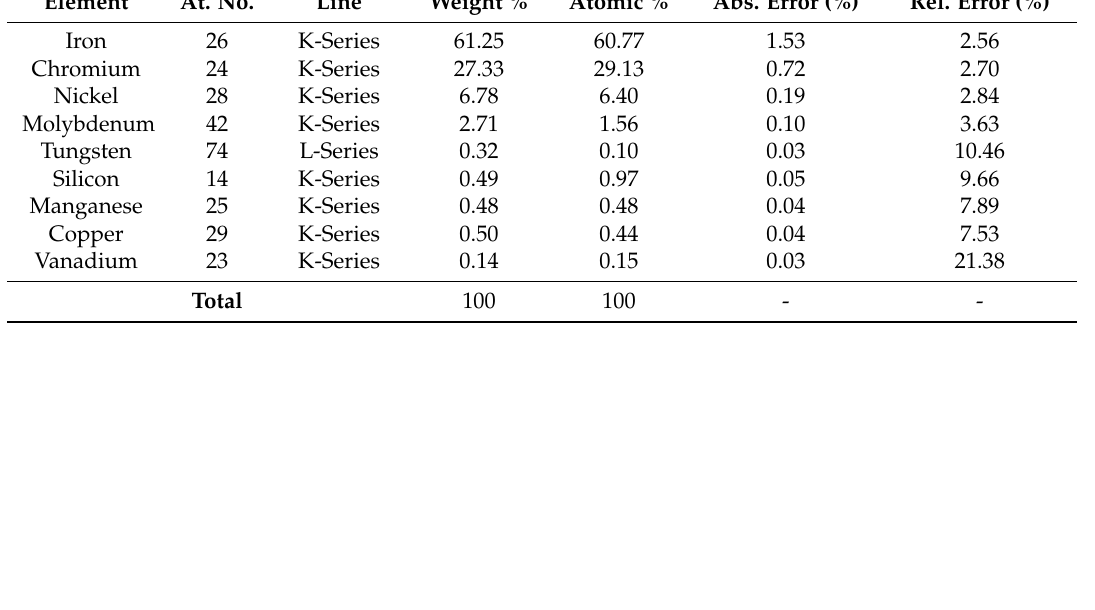
Table 1. The average chemical composition of the UNS S32750 steel in the initial state. Element At.